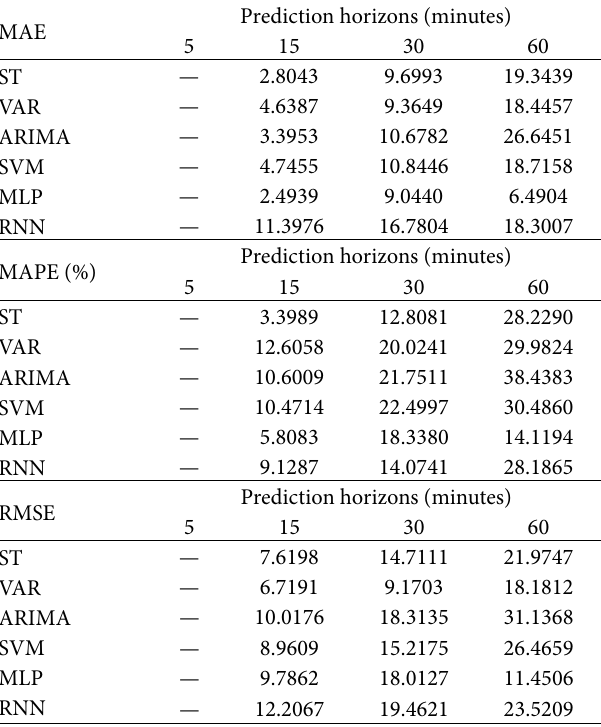
Table 2: Improvement percentage of hybrid models for different prediction horizons in peak hours at station C (time scale: 15